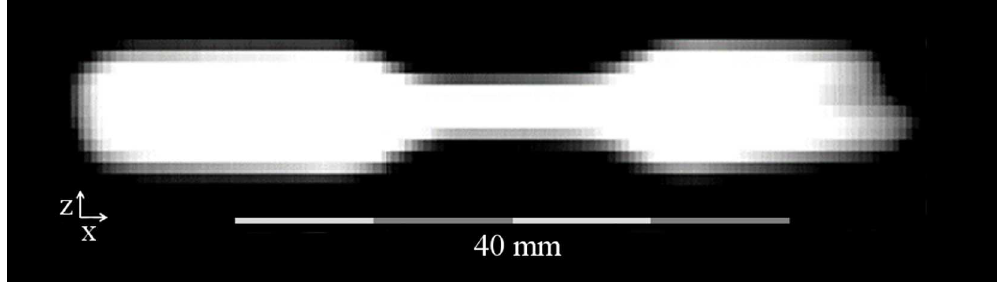
Fig 3. MPI image of the 5 mm stenosis phantom. Image of the 5 mm stenosis phantomreconstructed as covered by the focus fields in z-/x-plane. One end was not fully coveredas it extendedbeyondthe encodedvolume. It is thus blurry and wouldnot be used in a quantitative